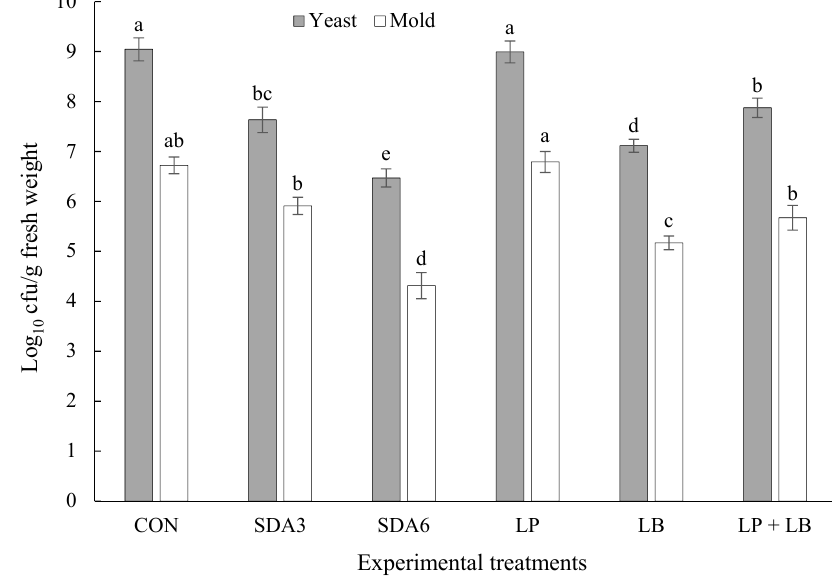
Figure 3. Agar-culturable counts of yeast and mold in early-harvested rye ensiled for 60 d with different additives after aerobic exposure. Experi - mental silages were untreated silage (CON); SDA3 = sodium diacetate at 3 g/kg fresh weight; SDA6 = sodium diacetate at 6 g/kg fresh weight; LP = L. plantarum ; LB = L. buchneri ; LP+LB = L. plantarum + L. buchneri (equal proportion). Inoculant application rate was 1,000,000 cfu/g fresh weight. a-e Within the same microbe, means (±standard deviation) with unlike superscripts differ (based on Duncan’s test; p<0.05).